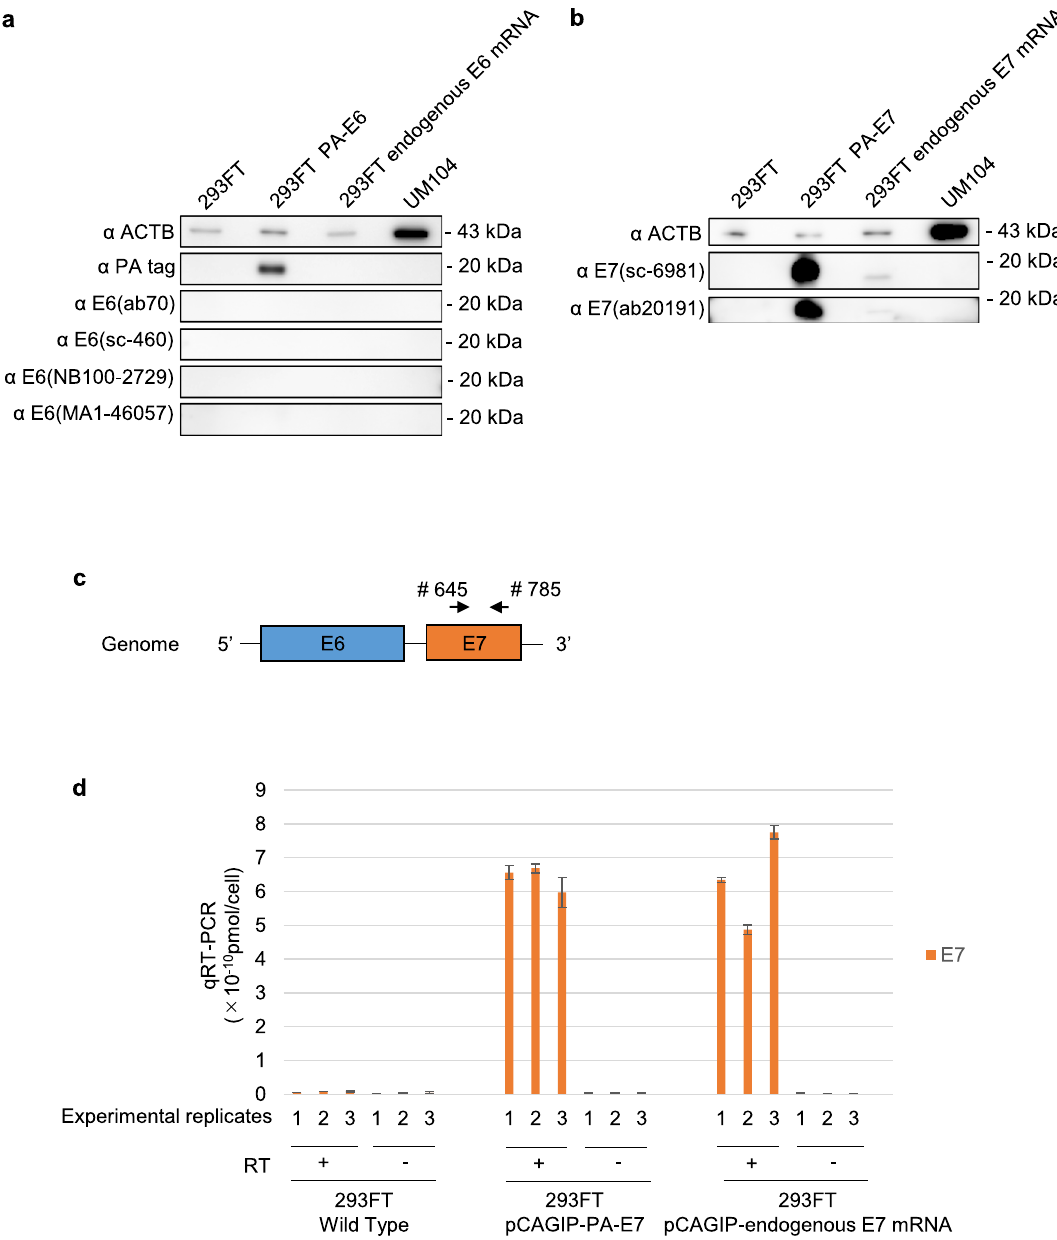
Figure 2. E7 protein expression in 293FT cells by overexpression of E7 mRNA having the endogenous structure. ( a , b ) Western blotting of E6 ( a ) and E7 protein ( b ) in 293FT cells (wild-type), 293FT cells transfected with pCAGIP-PA-E6/-PA-E7 or pCAGIP-endogenous E6/E7 mRNA, and UM104 cells. ( c ) E7 primers (# 645 and # 785) designed for binding within the E7 gene for use in qRT-PCR. ( d ) qRT-PCR analysis of E7 expression in 293 FT cells transfected with pCAGIP-PA-E7 or -endogenous E7 mRNA plasmids. The values for E7 expression per cell are shown. RT+, Reactions performed in the presence of reverse transcriptase. RT−, reactions performed in the absence of reverse transcriptase. The numbers on the x-axis show the experimental